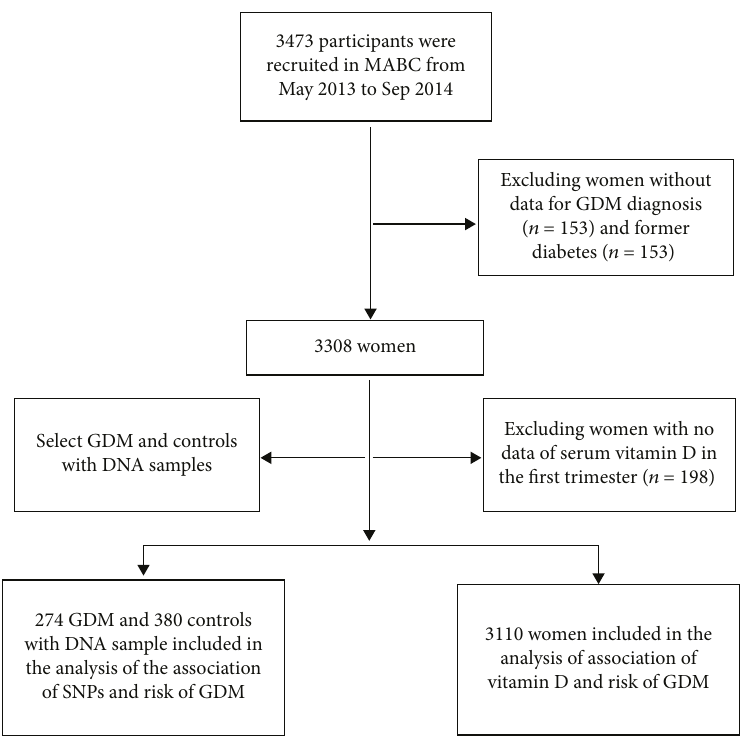
Figure 1: Flow chart of participant inclusion and exclusion of our